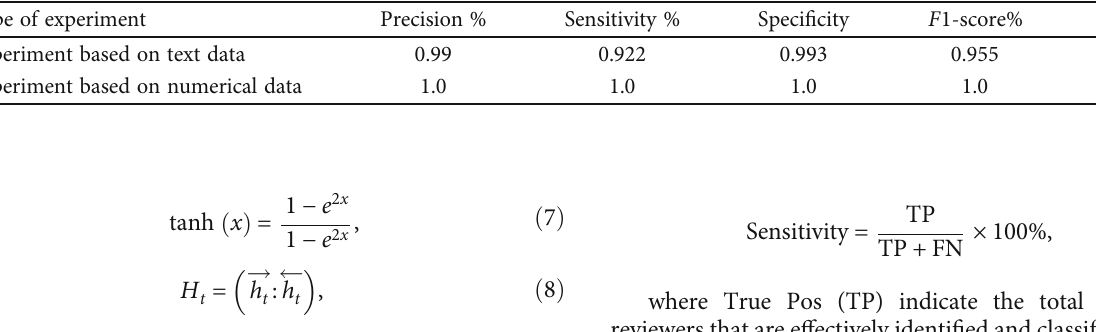
Figure 4: Confusion matrix of CNN-BiLSTM using numerical attributes. Table 3: Classi fi cation results of the CNN-BiLSTM